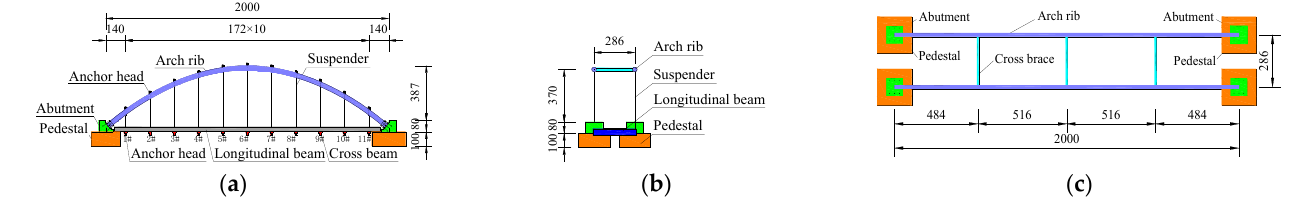
Figure 2. Overall layouts of the test specimen (unit: cm): ( a ) vertical view; ( b ) lateral view; ( c ) plane view.